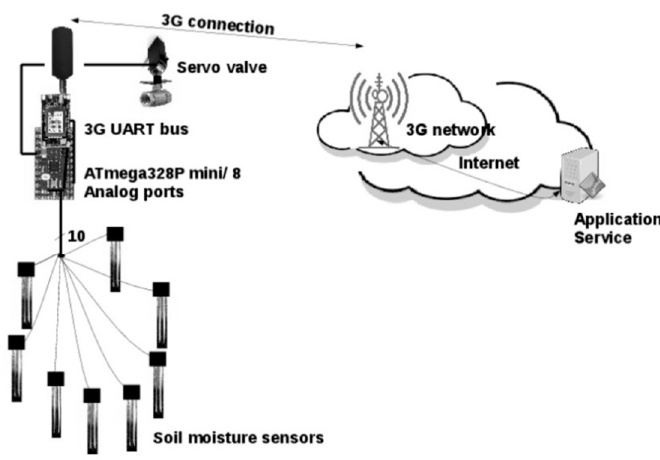
Figure 1. Proposed OWS (3G-UMTS) high-level system architecture. The authors are using a 3G UART transponder connected to the microcontroller software-serial interface.